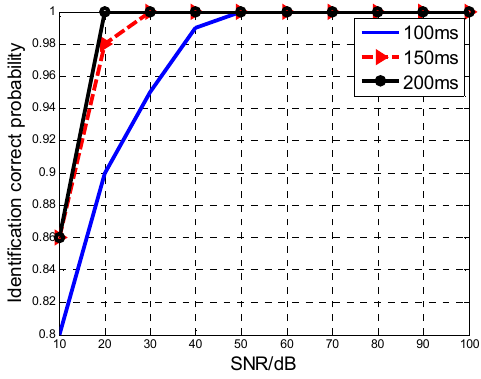
Figure 5. The MAF identification rate versus TOT.